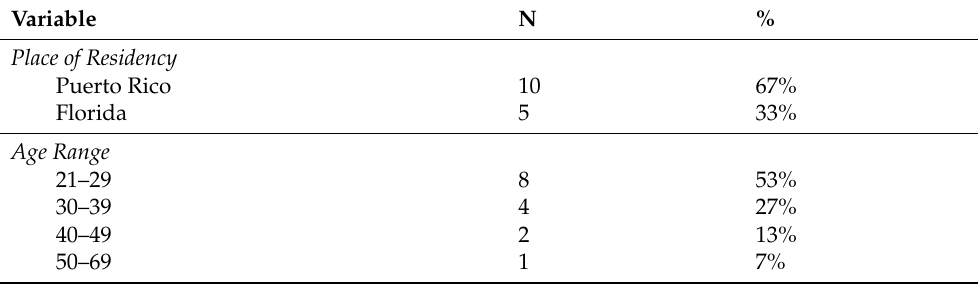
Table 3. Sample characteristics.